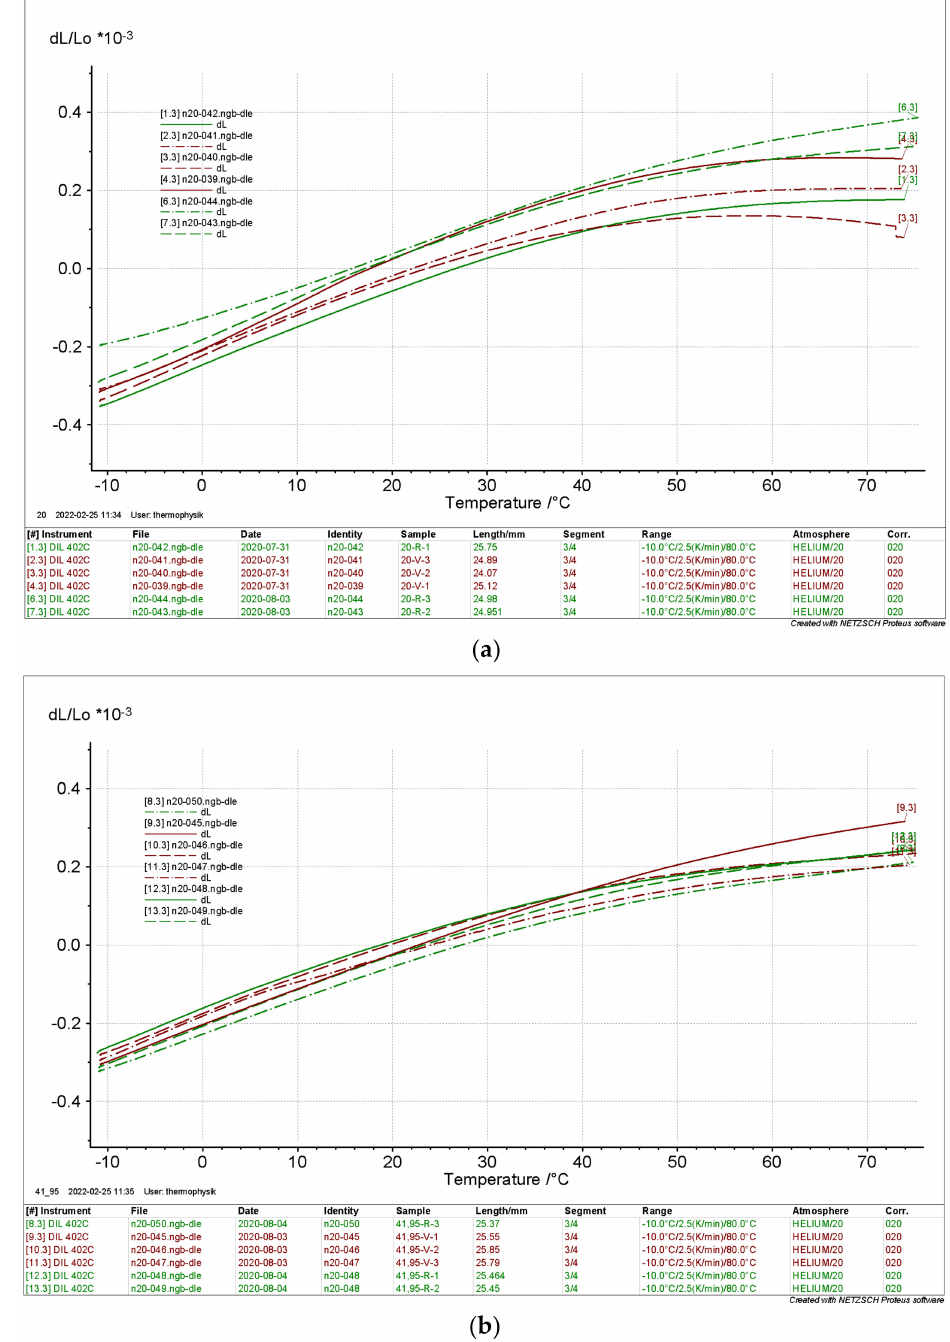
Figure 14. Summary of the results of the linear thermal expansion of dry drill core samples from depths of ( a ) 20 m and ( b ) 41.95